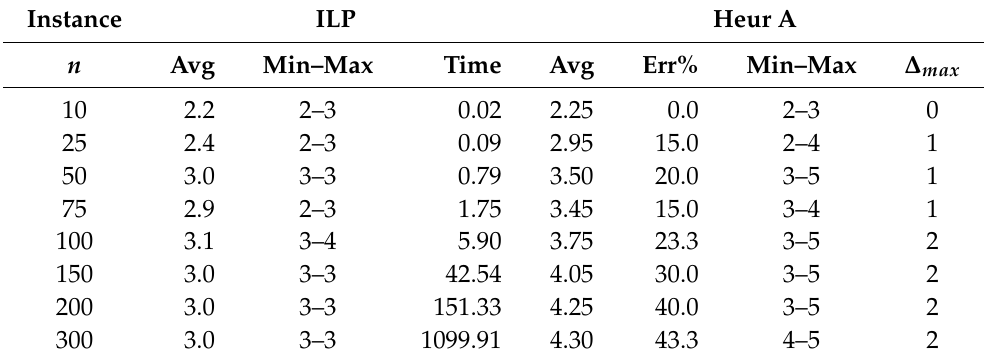
Table 1. Experimental results of ILP and Heuristic A on random instances.